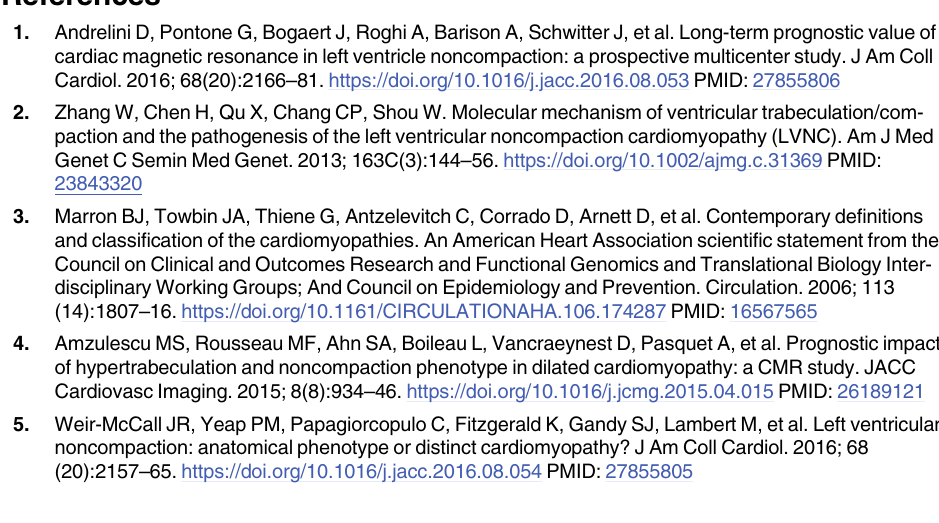
noncompacted layer mass m. H −